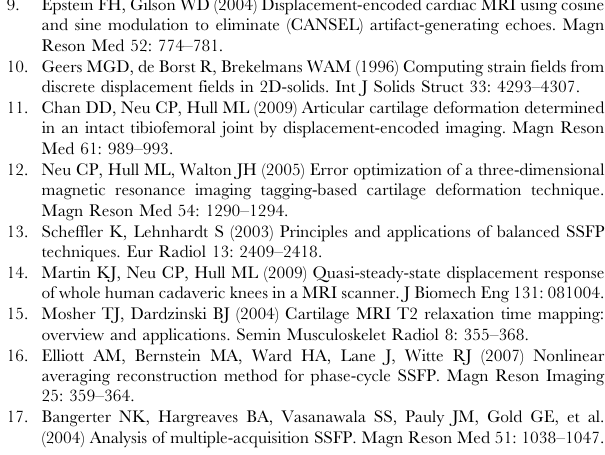
Figure S1 Parameters for displacement-encoded MRI synchronized with cyclic loading can be adjusted to match experimental questions and conditions. DENSE- FISP is synchronized with applied cyclic loading to measure displacements and strains. A series of radiofrequency (RF) and magnetic gradient actions (only displacement-encoding gradient shown) comprise the DENSE-FISP pulse sequence ( A ). Displace- ment is encoded prior to loading with an applied gradient ( G de ) in the direction of interest and decoded during image acquisition, which begins after the mixing time (TM). In particular, the RF coil acquires a single line of data (labeled ACQ-i,j) during each